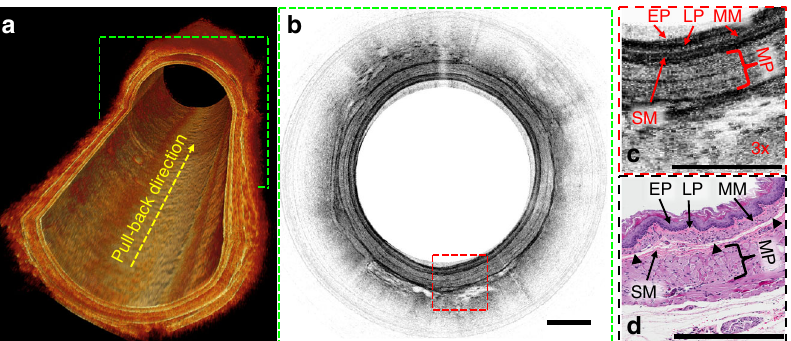
Fig. 6 In vivo imaging of rat esophagus. a Cut-away view of a reconstructed three-dimensional (3D) optical coherence tomography (OCT) image representing a 4 mm-long normal rat esophagus imaged with 20 µ m pullback pitch. b Representative in vivo two-dimensional (2D) OCT image of rat esophagus corresponding to green dashed lines boxed cross-section in ( a ). c 3x enlarged view of the area in b boxed by red dashed lines. d Corresponding haemotoxylin and eosin (H&E) histology. EP: keratinized strati fi ed squamous epithelium, LP lamina propria, MM muscularis mucosae, MP: muscularis propria, SM submucosa. The histology processing artifact is labeled with black triangles in d . All scale bars are 250 µ